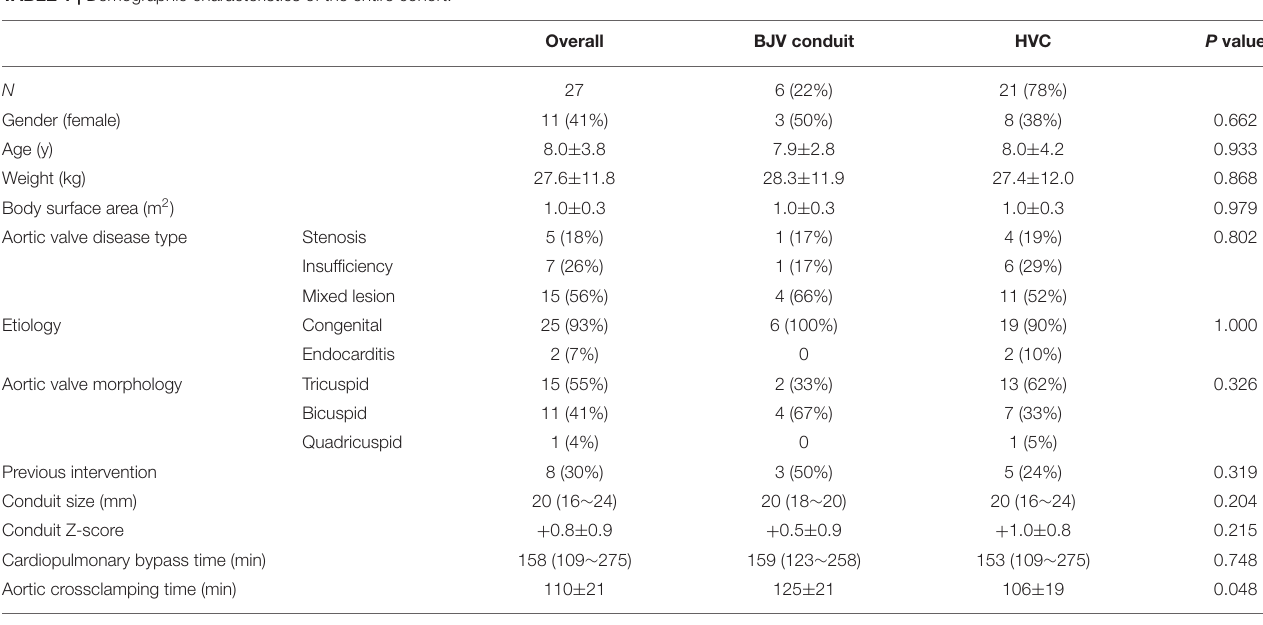
TABLE 1 | Demographic characteristics of the entire